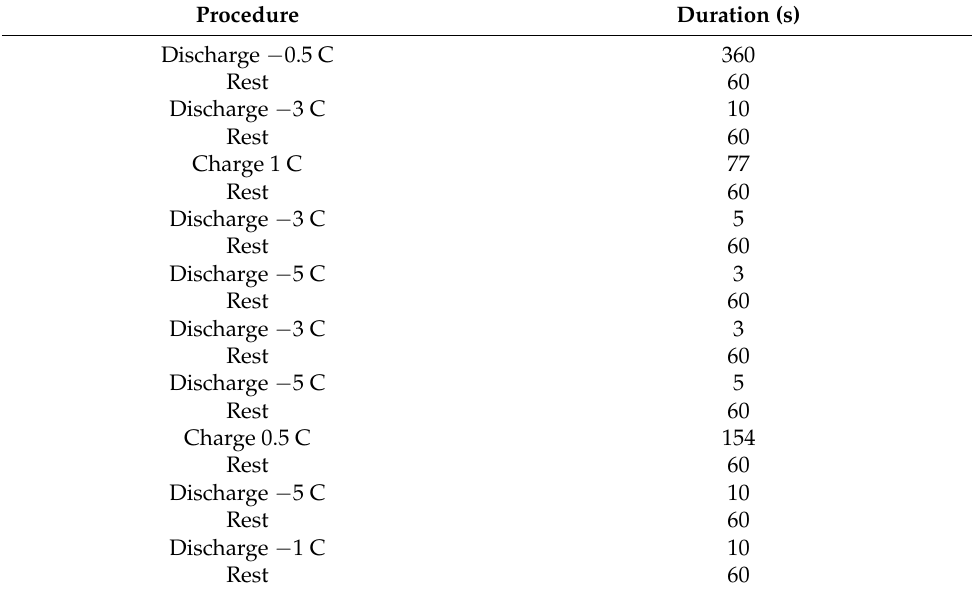
Table 2. Step specification of the AMPP